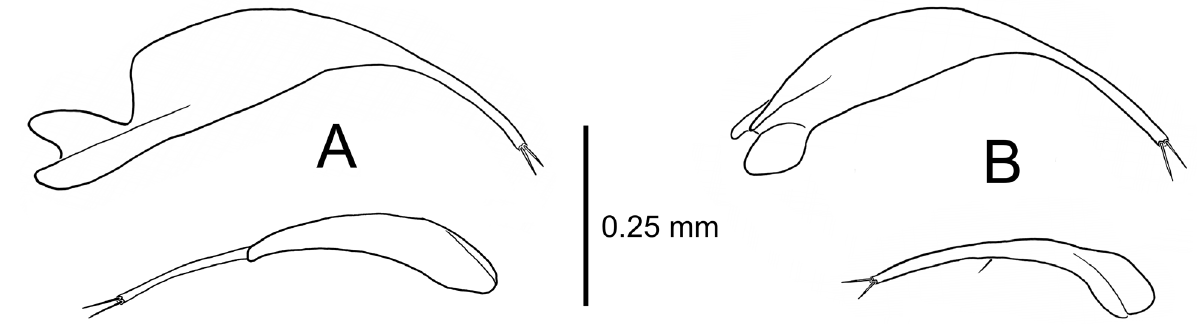
Figure 22. Paired left (above) and right (below) parameres of Mecyclothorax ( Phacothorax ) spp. (ectal view): A , M. kanak ; B , M. picdupinsensis